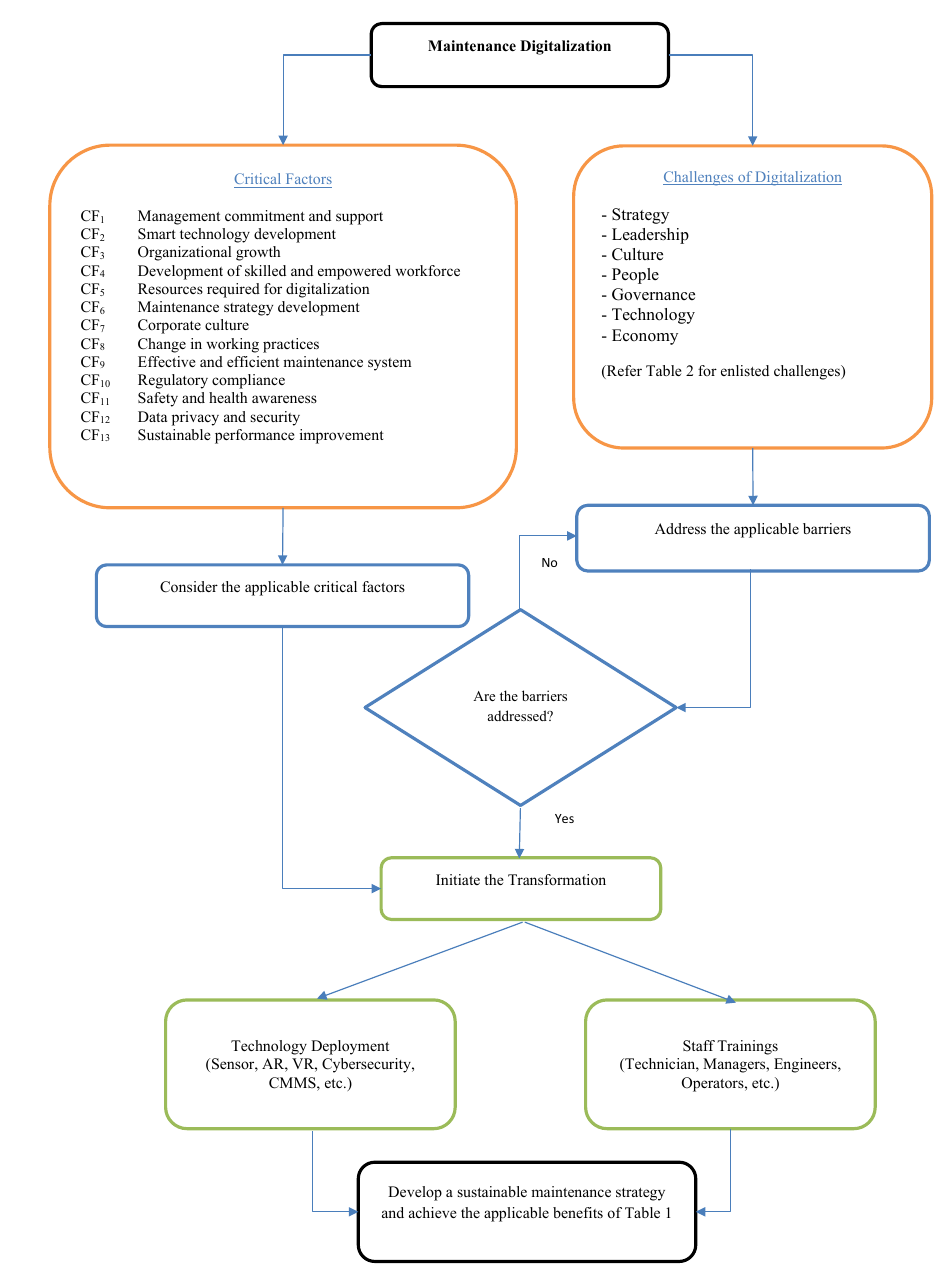
Figure 2. Feasible framework for maintenance